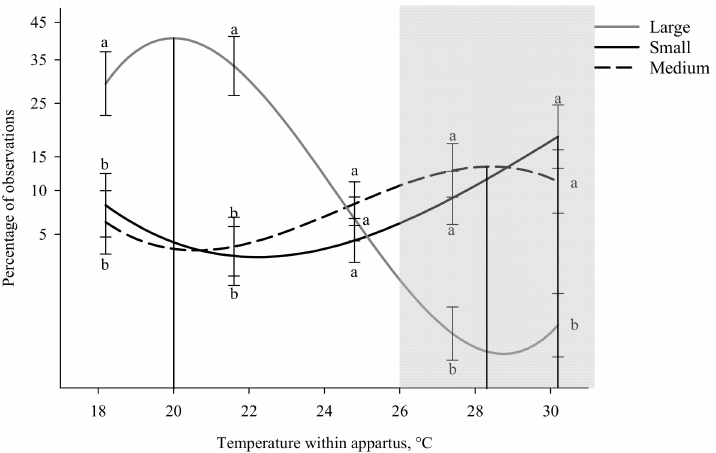
Figure 4. Percentage of observations in different temperatures within the thermal gradient while inactive based on weight category. The effects of being tested as a small group (3–7 kg), medium (7.1–11 kg) and large (11.1–15 kg), on temperature preference. Temperature within the thermal apparatus is plotted on the x axis and percentage of time spent are plotted on the y axis as a square root scale. Cubic peaks are indicated by vertical lines corresponding to group weight category. Standard error bars are located at the temperatures of the five thermal zones (18.2, 21.5, 24.8, 27.3, and 30.3 ◦ C) and different letters denote significant Tukey pairwise comparisons ( p < 0.01). The gray box indicates the recommended temperatures (26 to 32 ◦ C) for pigs between 3 and 15 kg [12]. Equations for the curves shown above can be found in Figure